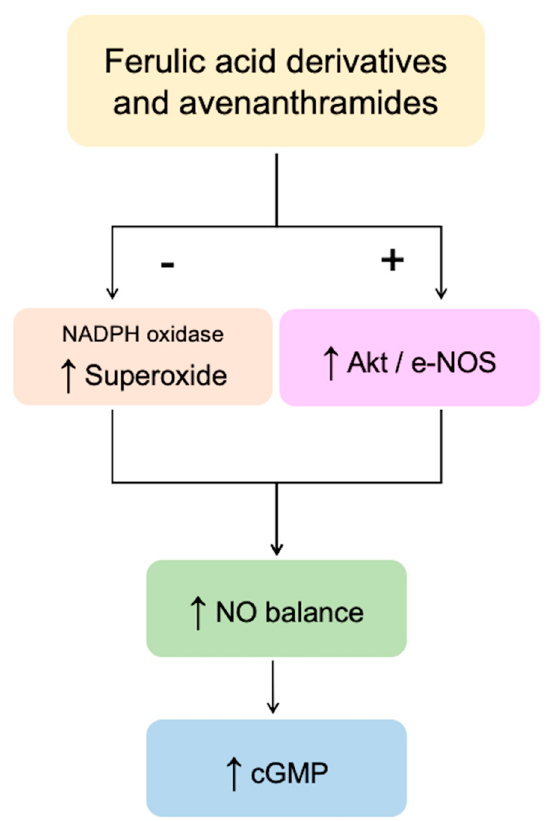
Figure 7. Schematic representation of the mechanisms involved in the modulation of endothelial NO levels by the oat phenolics and metabolites tested in the present study. + = activation; − = inhibition; ↑ = increased .